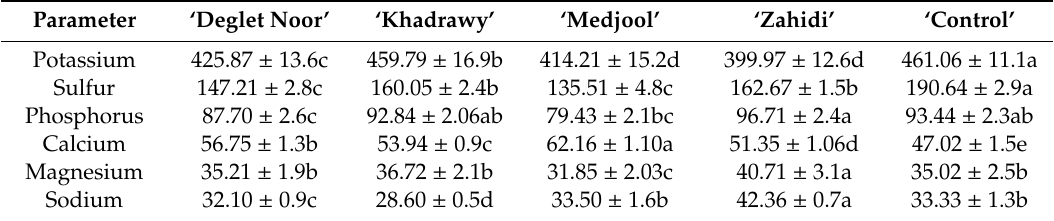
Table 5. Total macrominerals content for four pollen source treatments and control for a recipient ‘Medjool’ cultivar. Control is a pollen mixture from random date palm male plants, used by the grower. All parameters are expressed in mg / 100 g dry